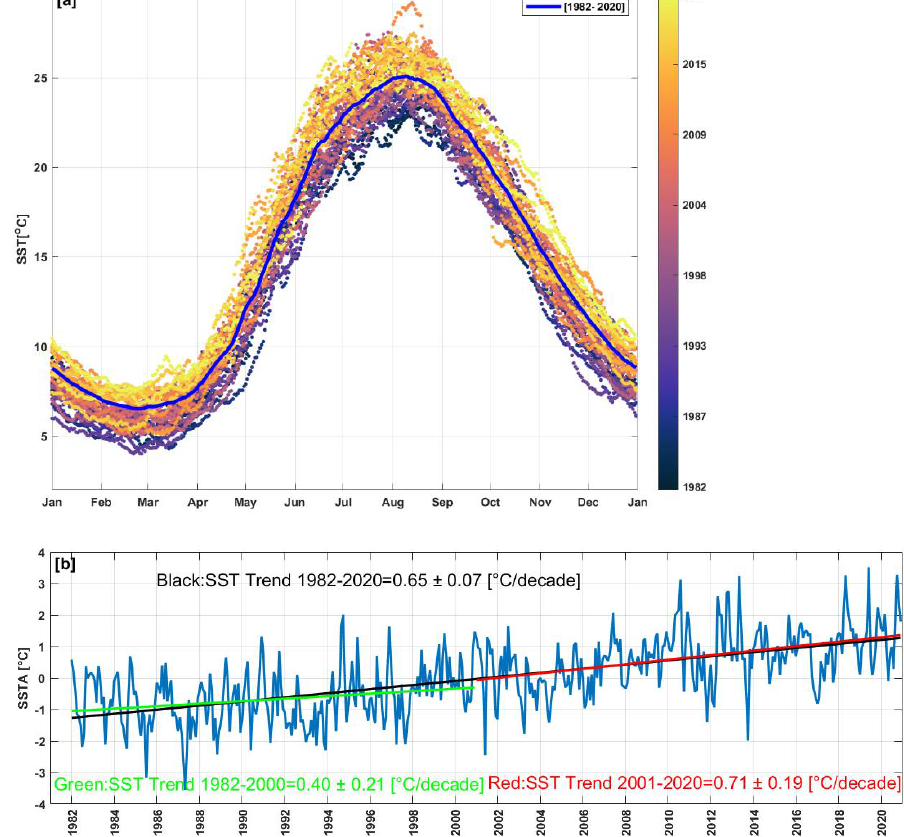
Figure 2. ( a ) Annual cycle for the mean Black Sea SST from 1982 to 2020. Each line represents a year in the study period, and the solid black line indicates the climatic mean. ( b ) The de-seasoned monthly SST time series (blue line) from 1982 to 2020, with the SST trend (black line). The green and red lines show the SST trends for 1982–2000 and 2001–2020, respectively.